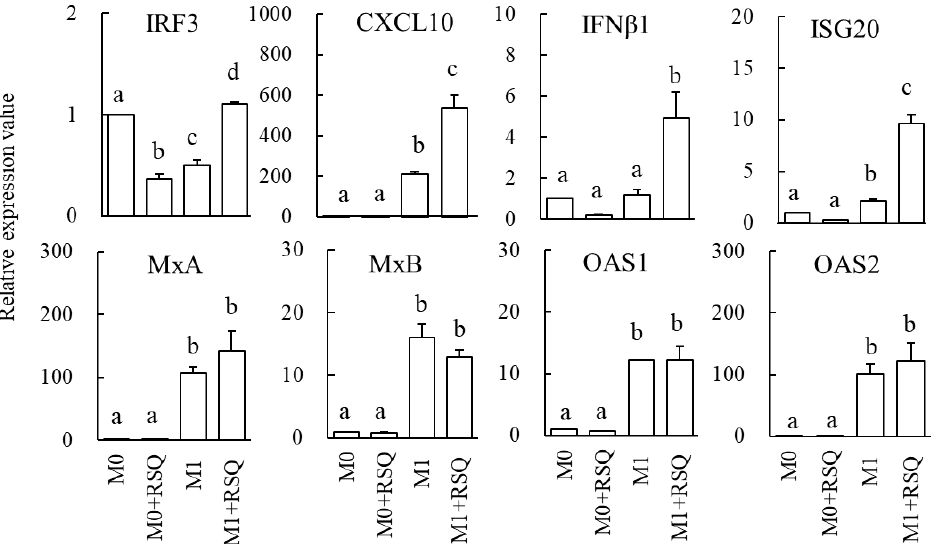
Figure 2. Effects of resiquimod (RSQ) on the expression of antivirus factor genes in M0 or M1-phenotype macrophages. M0 and M1-phenotype macrophages were cultivated in the presence of 1 μg/mL RSQ for 3 h. Quantitative real-time reverse transcription polymerase chain reaction assessed the relative expression values. The data are presented as the mean and SD ( n = 3). The comparison among multiple groups was evaluated using Tukey’s test posttest following ANOVA. Different letters represent a statistically significant difference, p < 0.05.